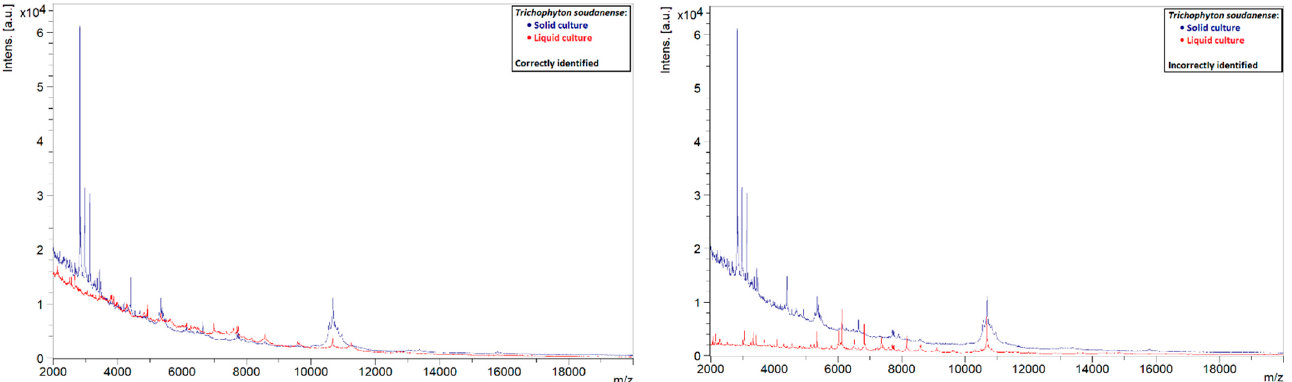
Figure 7. Comparison of the spectra of solid and liquid cultures of a T. soudanense strain, on the left a correctly identified liquid culture and on the right an incorrectly identified liquid culture.